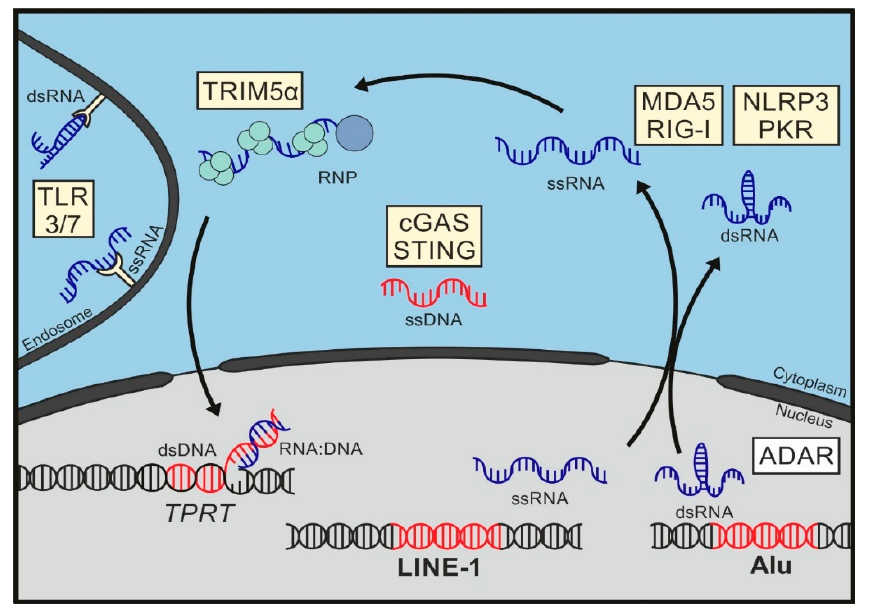
Figure 2. Sensing of LINE1 and Alu elements. Here, we give an overview of the different nucleic acids of LINE ‐ 1 and Alu elements and how they can be sensed by pattern recognition receptors (PRRs, yellow boxes) during retrotransposition. In the nucleus, LINE ‐ 1 and Alu sequences are transcribed by RNA polymerase II (LINE ‐ 1/Alu) or III (Alu), resulting in single ‐ stranded RNA molecules (ssRNA). Upon export to the cytoplasm, ssRNAs of both elements have been shown to activate double ‐ stranded RNA (dsRNA) sensors, such as melanoma differentiation ‐ associated gene 5 (MDA5) or retinoic acid ‐ inducible gene I (RIG ‐ I) under certain conditions. After translation, LINE ‐ 1 ribonucleoprotein complexes (RNPs) are formed and are composed of de novo synthesized ORF1p and ORF2p and the RNA molecule they have been translated from. Accumulation of excess RNPs is sensed by human tripartite motif ‐ containing 5 α ( TRIM5 α ) in the cytoplasm. RNPs are imported into the nucleus, where the process of target ‐ primed reverse transcription (TPRT) takes place to allow integration of LINE ‐ 1 at a new genomic location. During this process, genomic DNA is cleaved by ORF2p, liberating a 3´OH group, which is used to initiate reverse transcription. This might result in the formation of immunogenic RNA/DNA hybrid structures. LINE ‐ 1 single ‐